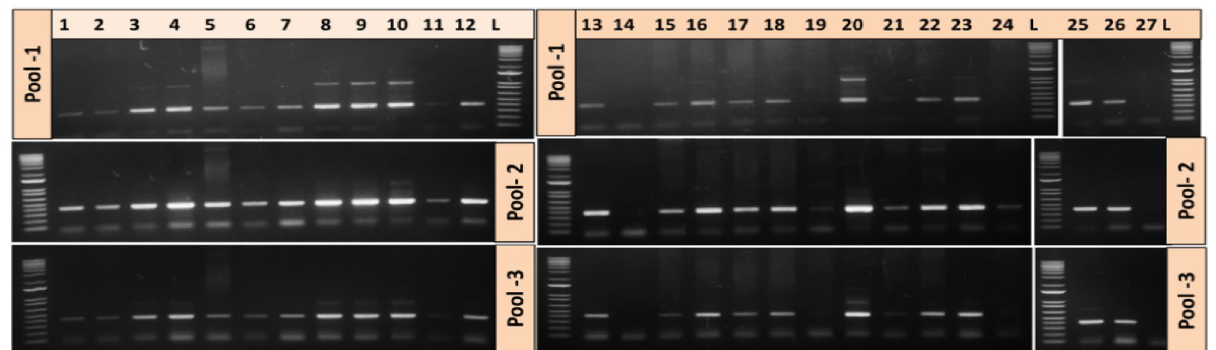
Figure 2. Agarose gel electrophoresis of various amplicons of representative positive samples generated using SARS-CoV-2 specific primer pools. These amplicons were further used for nanopore